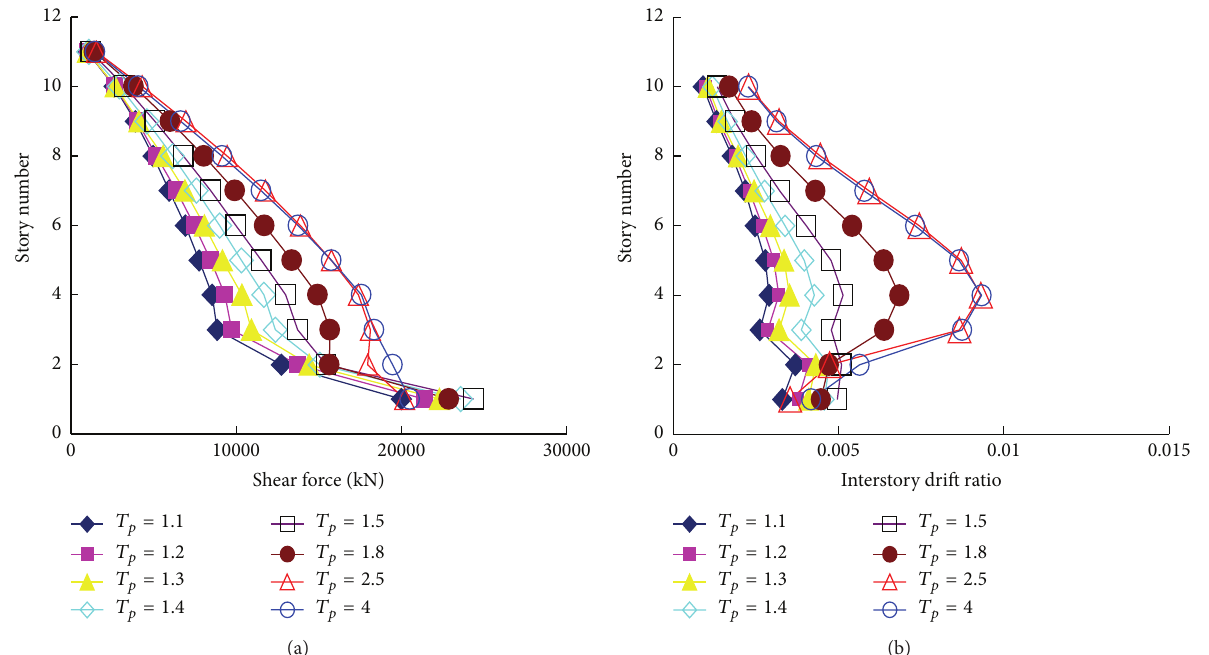
Figure 9: Effects of 𝑇 𝑝 on dynamic responses of the midstory isolated structure. (a) Peak shear force along height of building; (b) plastic interstory drift